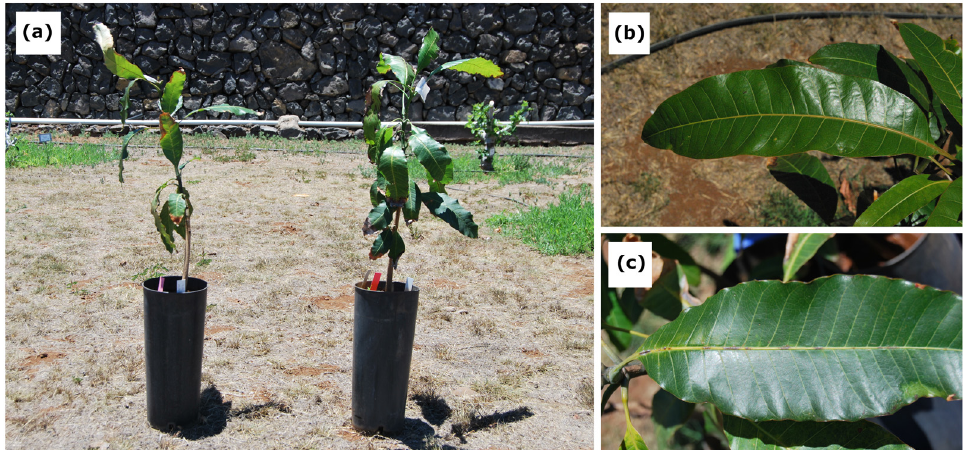
Figure 1. ( a ) ‘Gomera-1’ tetraploid plants after 33 days without irrigation (left) and watered until field capacity (right), just before the start of the recovery period. ‘Gomera-1’ ( b ) diploid and ( c ) tetraploid leaves. Note that tetraploid leaves have wider lamina and sinuate margins (non-scaled images).